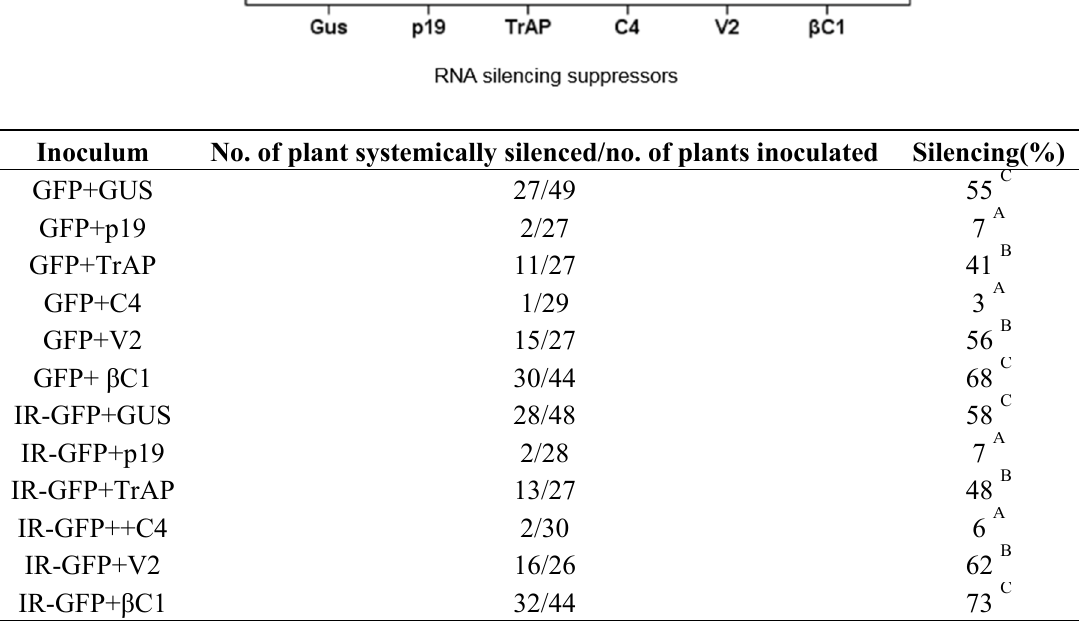
Figure 2. Suppression of systemic silencing. The bar graph shows the percentages of N. benthamiana 16c plants exhibiting systemic silencing at 14 dpi with silencing inducer and constructs for the expression of β -glucuronidase (GUS), the p19 protein of TBSV (p19), the β C1 protein encoded by Cotton leaf curl Multan betasatellite, or the transcriptional activator protein (TrAP), C4 protein (C4), or V2 protein (V2) encoded by Cotton leaf curl Kokhran virus . The raw data is shown in tabulated form below the graph. The results are of five independent experiments. Plants were examined for systemic silencing at 14 dpi. Error bars represent significant differences in suppression efficiency between the individual constructs and the empty vector in Chi-square tests ( p < 0.05). A,B,C: Indicates statistically significant differences at the 95%